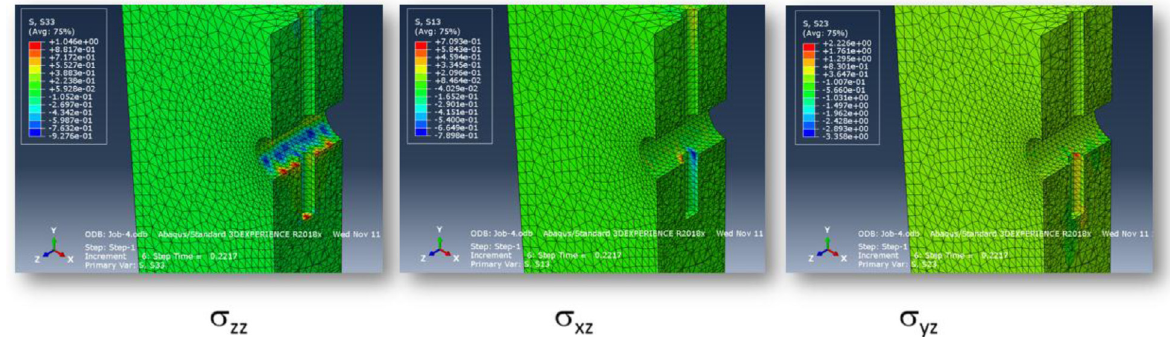
Fig. 19. Stresses s zz , s xz and s yz in the wooden part of the